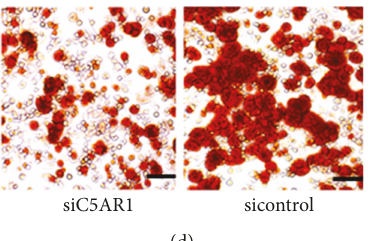
Figure 6: The inhibition of C5AR1 suppressed the osteogenic di ff erentiation of ASCs. (a) The expression of C5AR1 mRNA and protein was signi fi cantly increased during osteogenic di ff erentiation of ASCs. (b) The expression level of C5AR1 mRNA and protein was dramatically downregulated following siC5AR1 transfection. (c) C5AR1 downregulation inhibited the expression of osteogenic di ff erentiation markers. (d) C5AR1 downregulation suppressed the calcium nodule formation capacity of